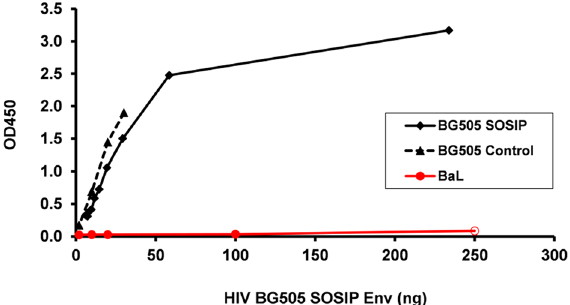
Figure 1. ELISA assay for the detection of plant derived HIV BG505 SOSIP Env trimers. Wells were coated with PGT145 and binding of samples (plant-BG505: black diamonds with solid line; CHO-BG505: black triangles with dashes line; monomeric BaLgp120: red circles with solid line) was revealed by biotinylated